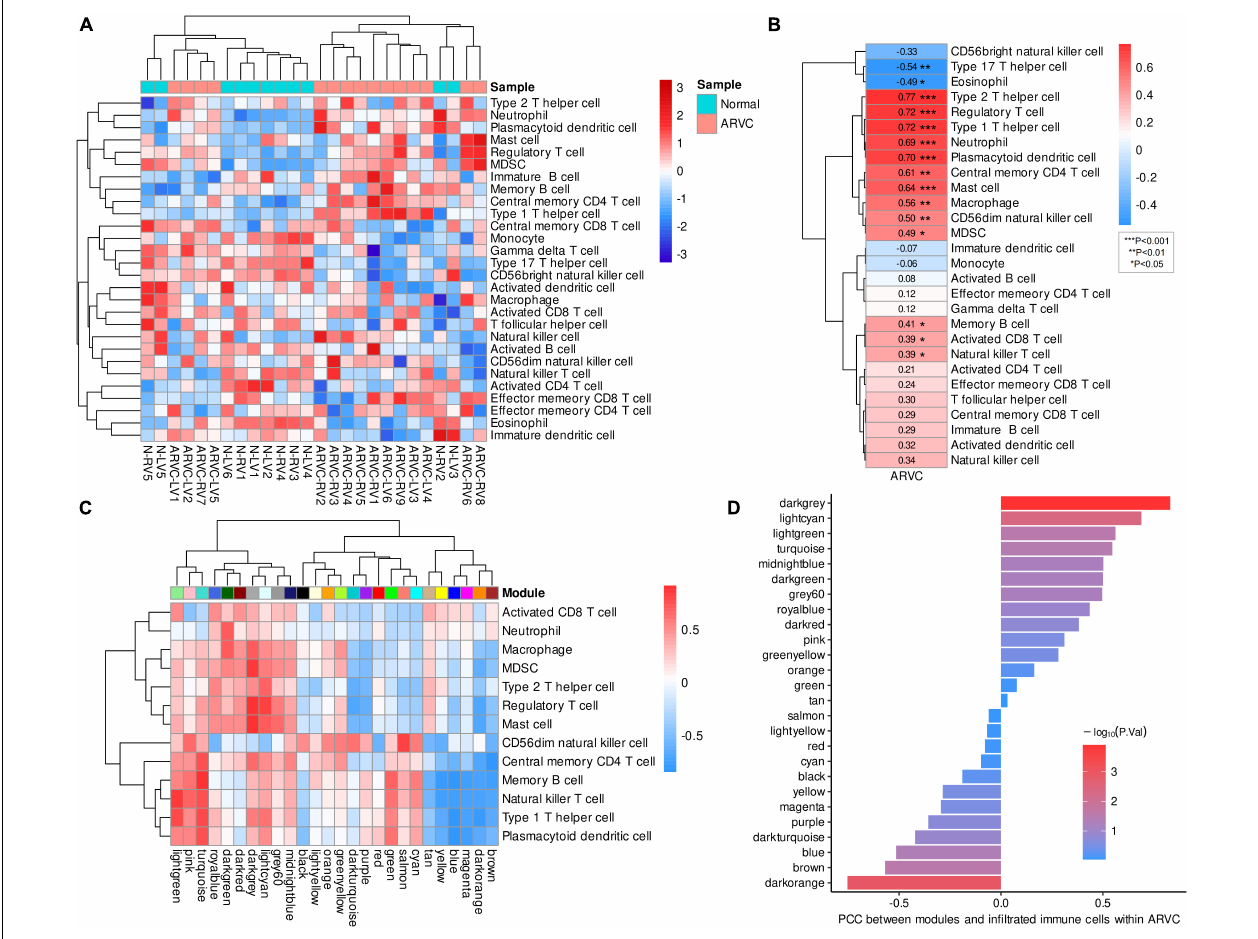
FIGURE 4 | Immune cell infiltration and immune-module correlation analysis. (A) Heatmap of the ssGSEA scores of 28 types of immune cells with inter-sample standardization, a higher score means the immune cell is highly infiltrated. (B) Correlation between ARVC phenotype and immune cell scores. (C) Correlation analysis between modules and the highly infiltrated immune cells within ARVC samples. (D) Correlation between moduless and the total score of the highly infiltrated immune cells within ARVC samples. MDSC, myeloid-derived suppressor cells; PCC, Pearson’s correlation